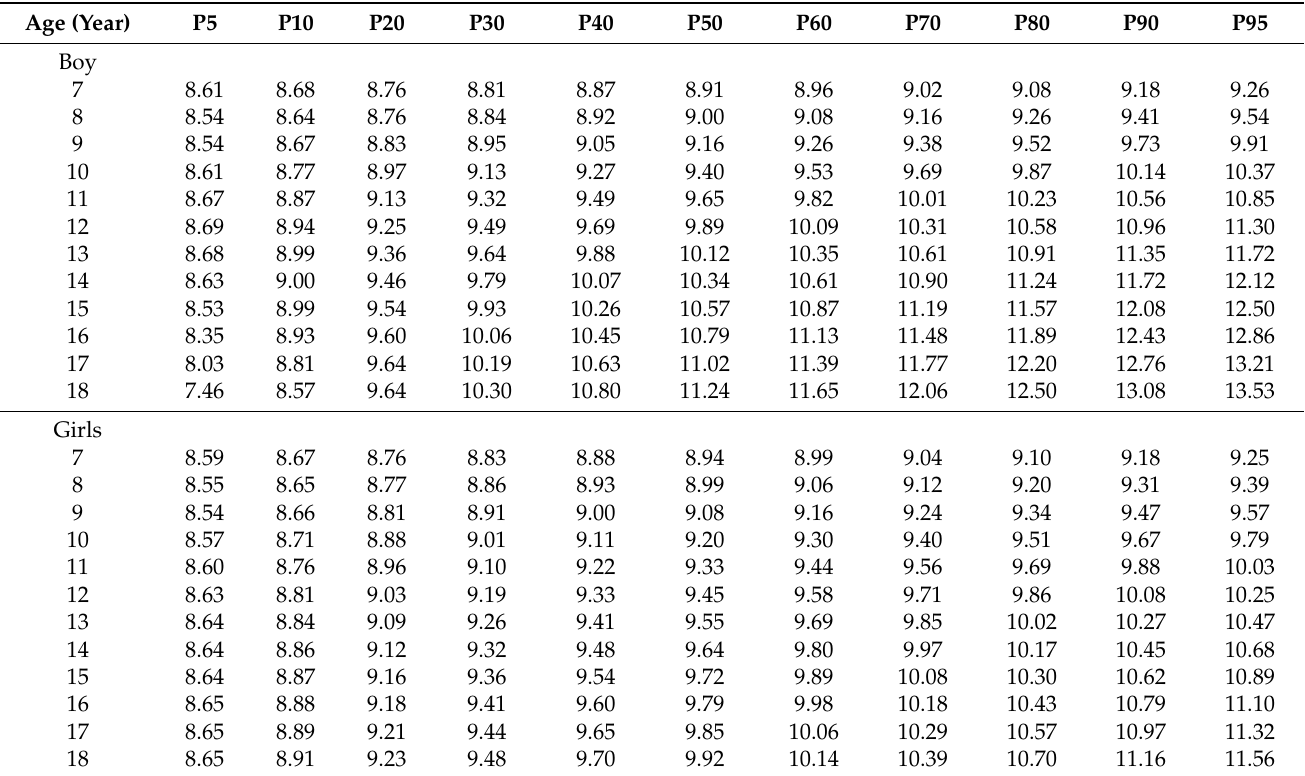
Table 3. Percentile values of the speed at the last complete stage (km h − 1 ) for Chinese Tibetan children and adolescents aged 7–18 in Tibet, China.